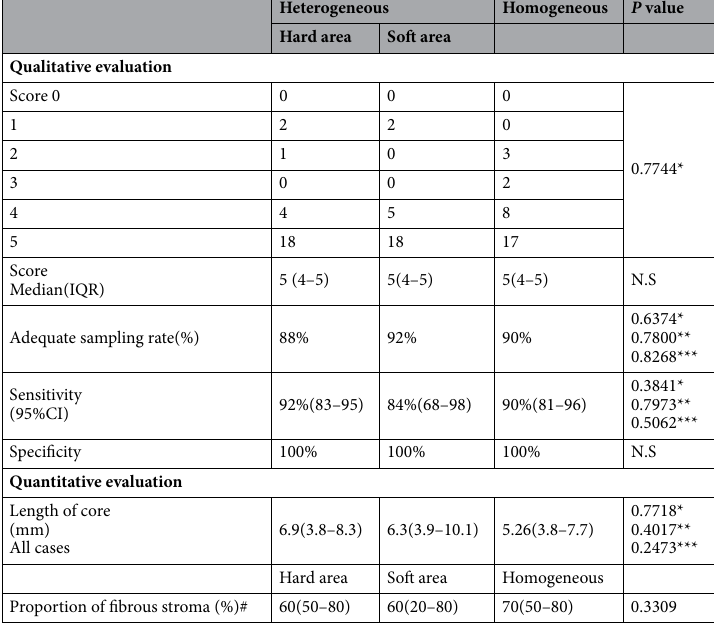
Table 3. Pathological findings. *Hard versus Soft, **Hard versus Homogeneous, ***Soft versus Homogeneous. # Proportion of fibrous stroma in the core tissue.